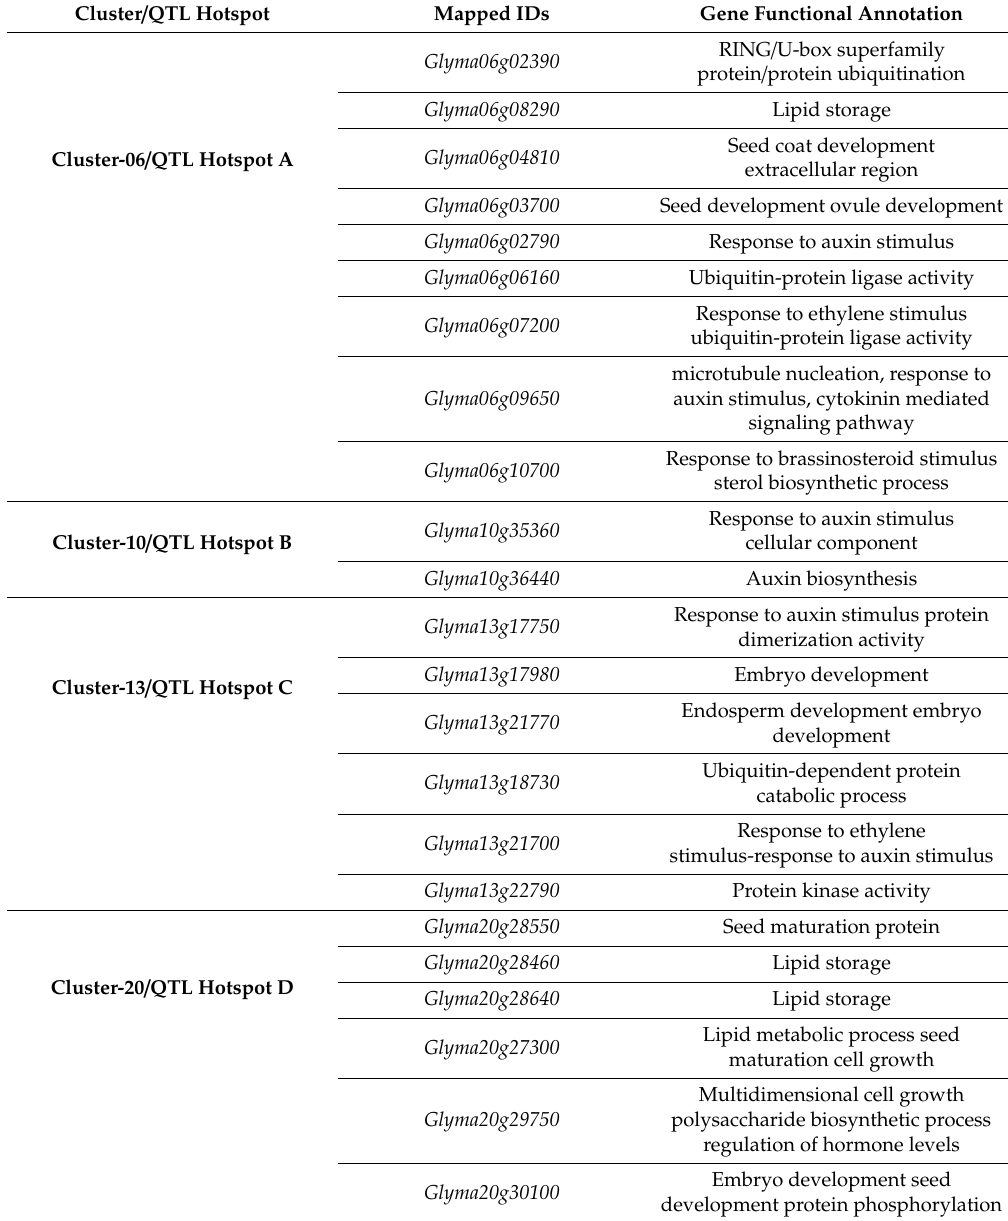
Table 6. Predictive gene annotation